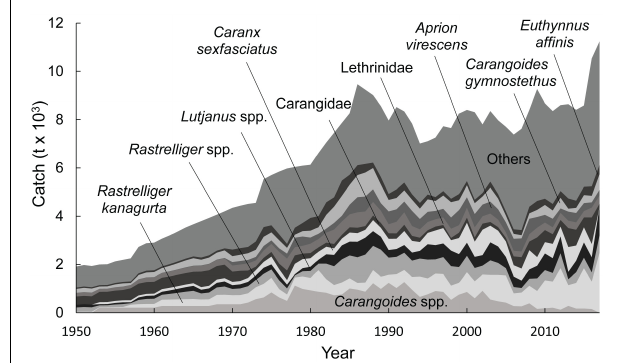
FIGURE 3 | Taxonomic composition of reconstructed total catches for Seychelles for 1950–2017. The category “Others” consists of 82 additional taxa with minor contributions to the overall catch.